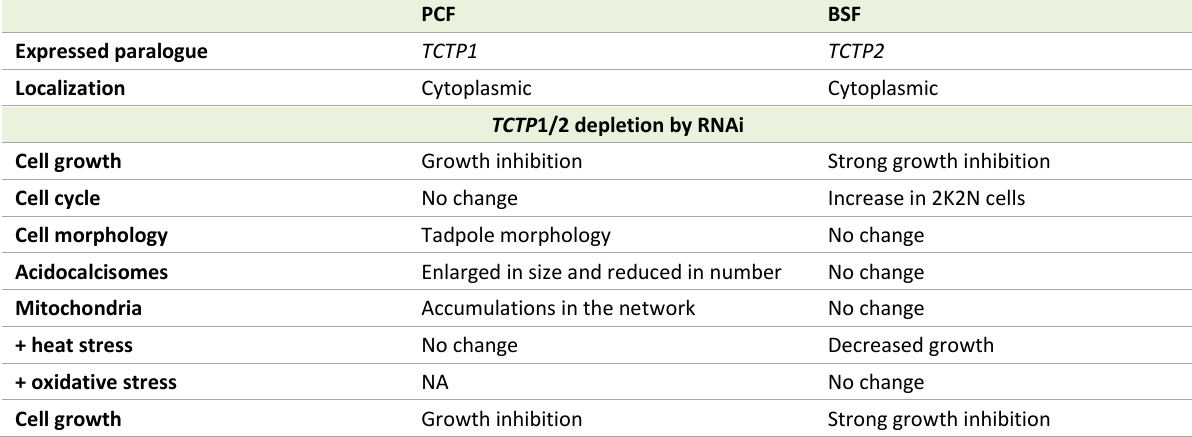
TABLE 1. Comparison of TCTP1 and TCTP2 in PCF and BSF parasites,